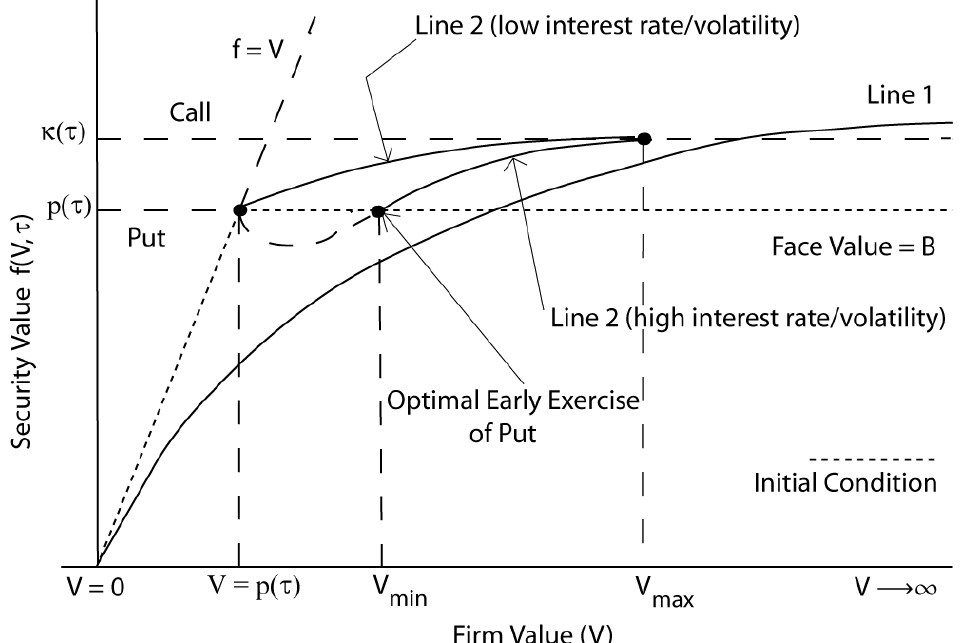
Figure 2. Schematic representation of the optimal exercise of the call and put options. f ( V , τ ) repre- sents the bond’s value; V represents the firm’s value; τ represents the time-to-maturity. The valuation function is represented by the solid lines labeled 1 and 2. Line 1 depicts the valuation function when both the call provision ( κ ( τ ) and the put provision ( p ( τ ) are inactive. Line 2 depicts the valuation function when both provisions are active (two characteristic forms are shown, corresponding to low interest rates and/or volatility—the upper line; high interest rates and/or volatility—the lower line). When the put provision is active, early exercise of the put at V min (i.e., before the firm’s value drops to V = p ( τ ) ) may be optimal for sufficiently high interest rates and/or volatility. Conversely, when the call provision is active, early exercise of the call at V max (prior to maturity) may be optimal for sufficiently low interest rates and/or volatility.